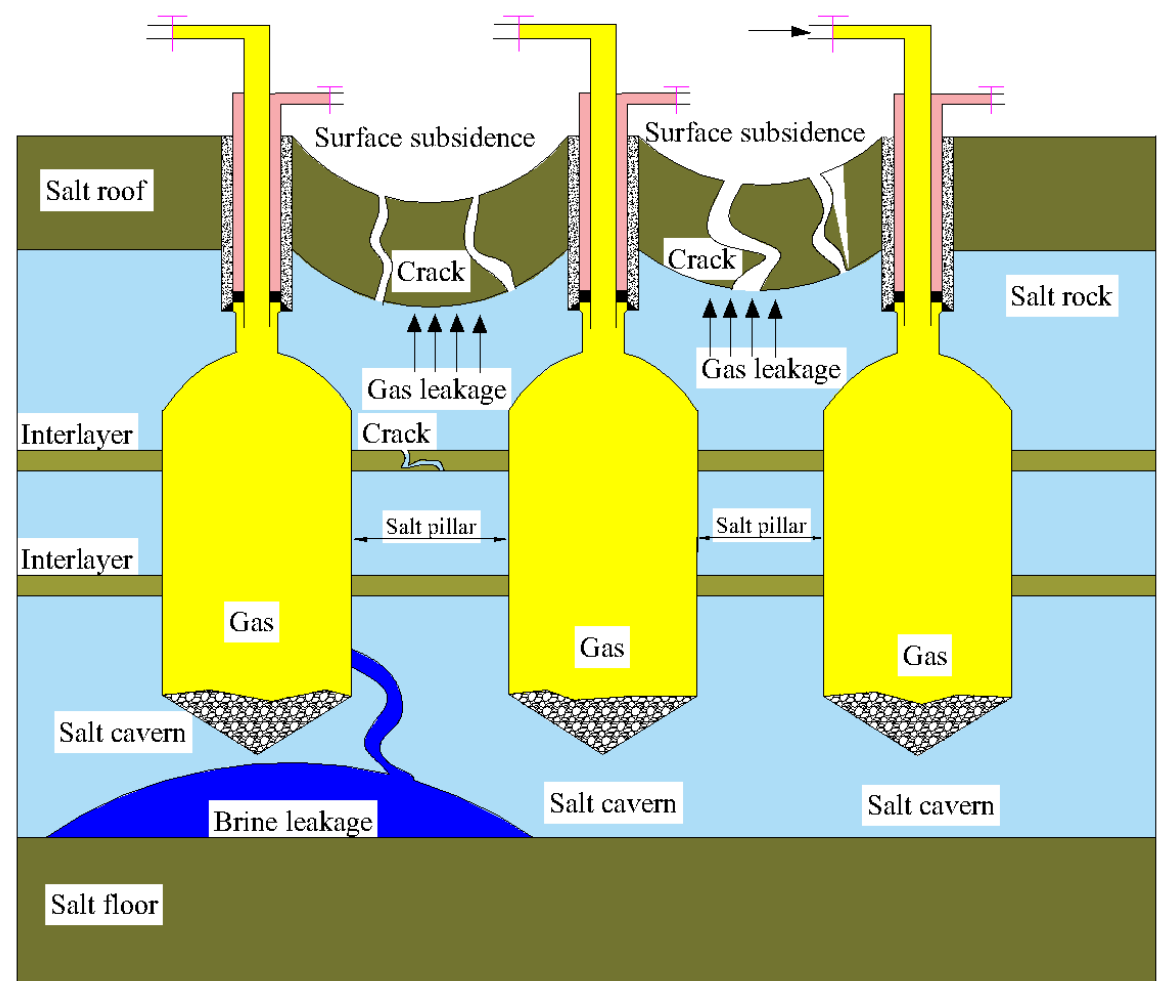
Figure 4. Destruction form of the instability salt pillar.